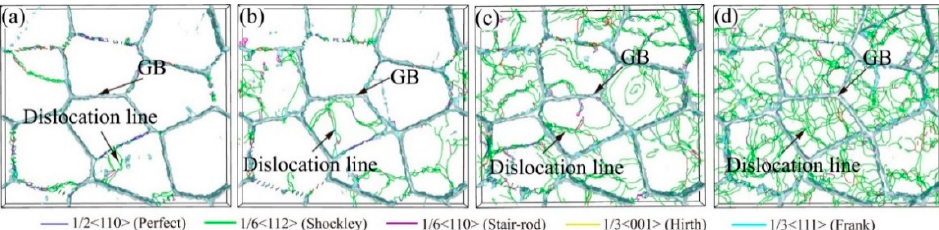
Figure 19. The dislocation lines of the sample with grain size d = 16.0 nm at ε = 12% under different strain rates loading. ( a ) 5 × 10 8 s − 1 , ( b ) 10 9 s − 1 , ( c ) 5 × 10 9 s − 1 , ( d ) 10 10 s − 1 .